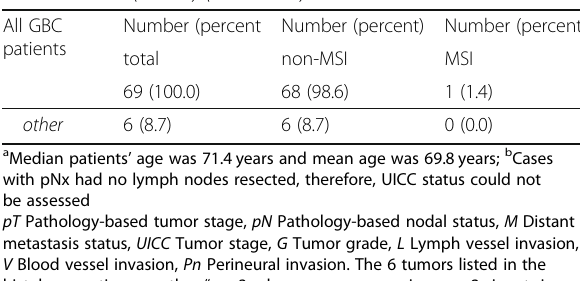
Table 1 Clinicopathological data of the gallbladder carcinoma cohort with complete clinicopathological data and correlation